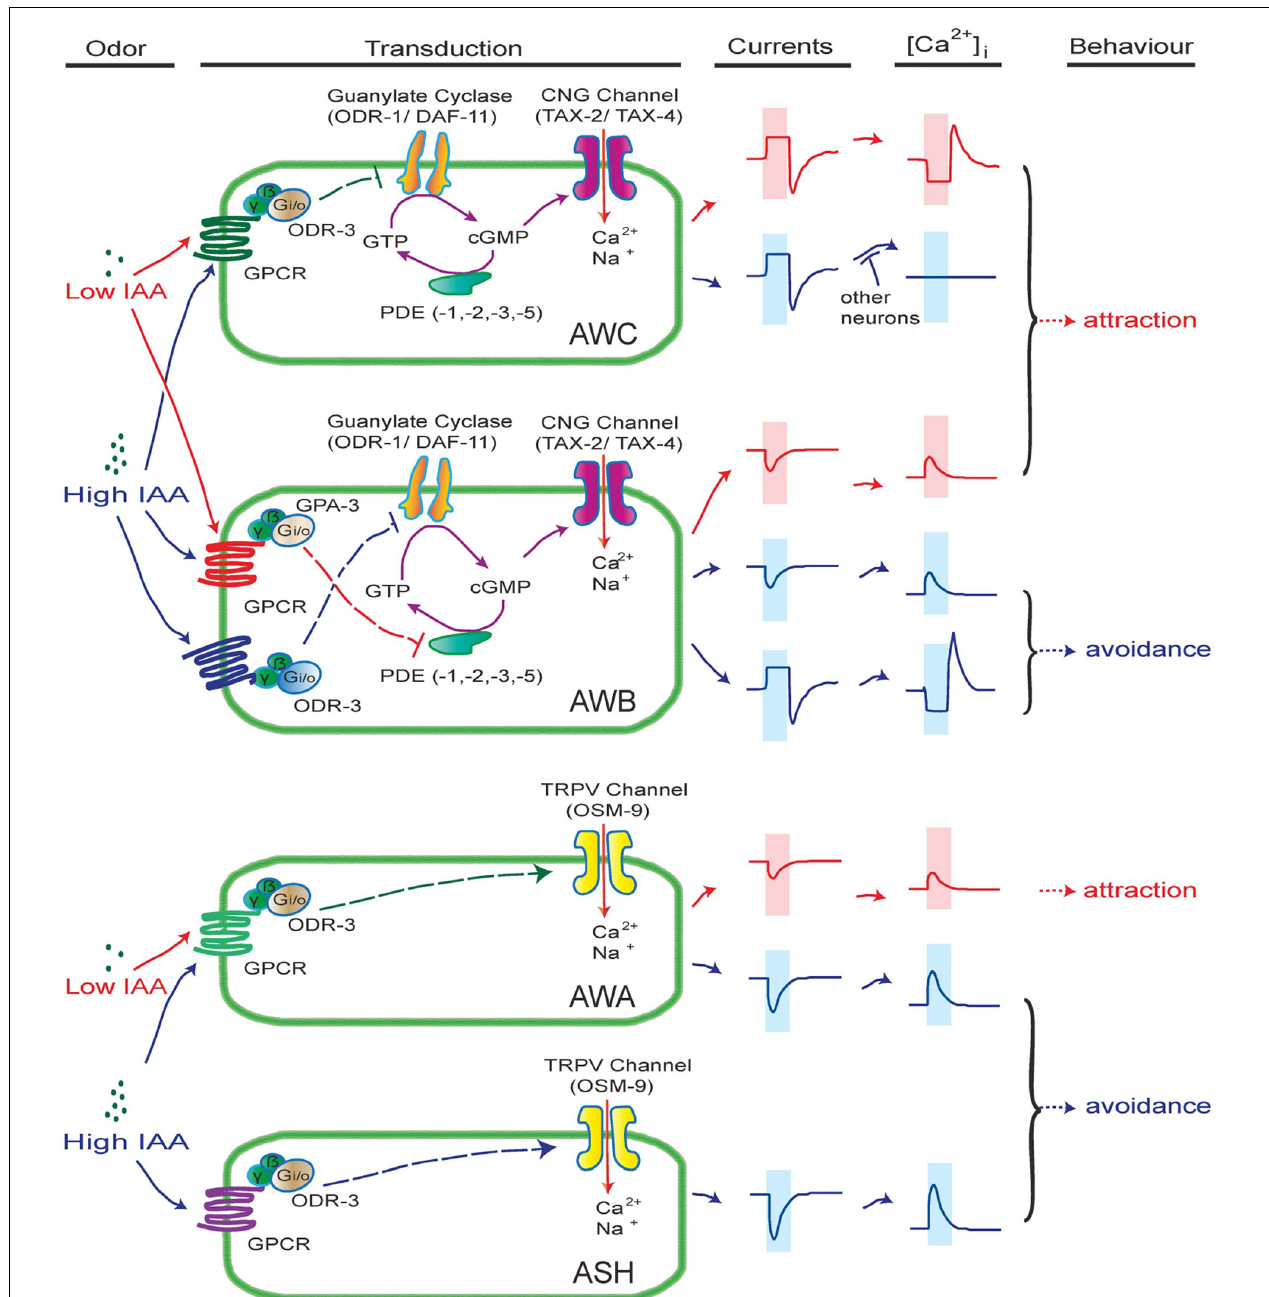
FIGURE 7 | A working model of intensity-dependent olfactory encoding in C. elegans . In this model, different receptors (GPCRs) with different affinities are expressed in olfactory neurons. G α proteins ODR-3 and GPA-3 are differentially associated with the receptors. The CNG channel TAX-2/TAX-4 is constantly open in resting state in AWB and AWC neurons. In AWC neurons, binding of IAA to its receptor mainly activates G α ODR-3, thereby inhibiting the activity of membrane GCs ODR-1/DAF-11. Consequentially, cGMP synthesis is reduced, thereby closing cGMP-gated CNG channel TAX-2/TAX-4 and hyperpolarizing AWC. PDEs set the basal level of cGMP in AWC and modulate the kinetics of IAA-induced response. Removal of IAA relieves the inhibition of GCs and leads to depolarization of AWC. In AWB neurons, low concentrations of IAA may bind to a high affinity IAA receptor, which is associated with G α GPA-3, thereby inhibiting PDEs and increasing cGMP. Thus, more CNG channels open and AWB neurons get depolarized. High concentrations of IAA may bind to both high and low affinity IAA receptors. When G α ODR-3-associated low affinity receptor is activated, the activity of membrane GCs are inhibited, thereby hyperpolarizing AWB via a pathway similar to that in AWC. In addition, a high affinity IAA receptor and a low affinity IAA receptor are likely expressed in AWA and ASH neurons, respectively, which are associated with ODR-3. Activation of ODR-3 leads to closure of TRPV channel OSM-9, thereby depolarizing and activating AWA and ASH neurons. Note that the IAA receptors expressed in AWB, AWC, ASH and AWA neurons may be